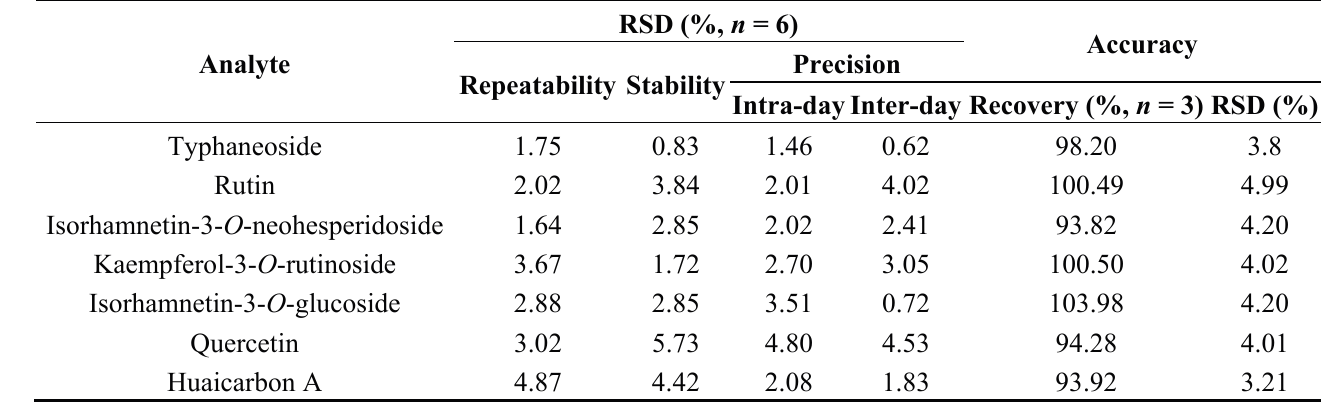
Table 4. Validation data including repeatability, stability, precision and recovery for the determination of the